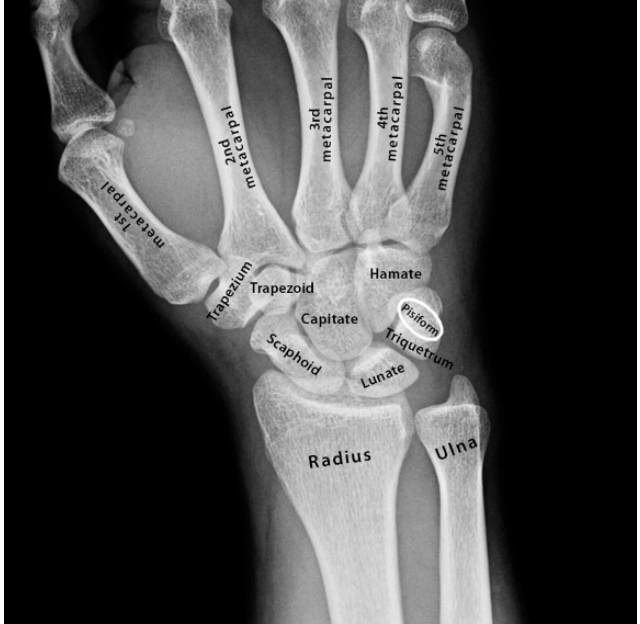
Figure 2. Bones of the human hand and wrist by TheSkeletalSystem.net (accessed on 10 June